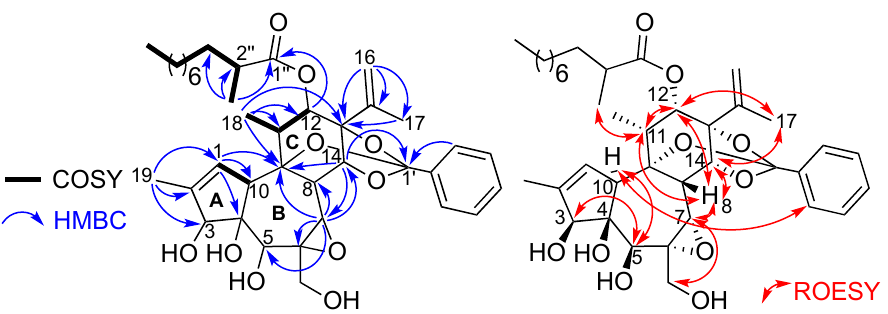
Figure 2. Key HMBC and COSY (left), and ROESY (right) correlations of compound 1